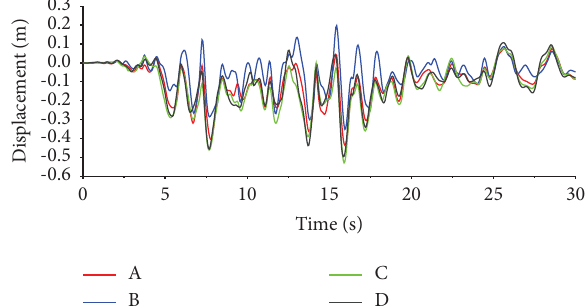
Figure 7: Total displacement time-history curve.